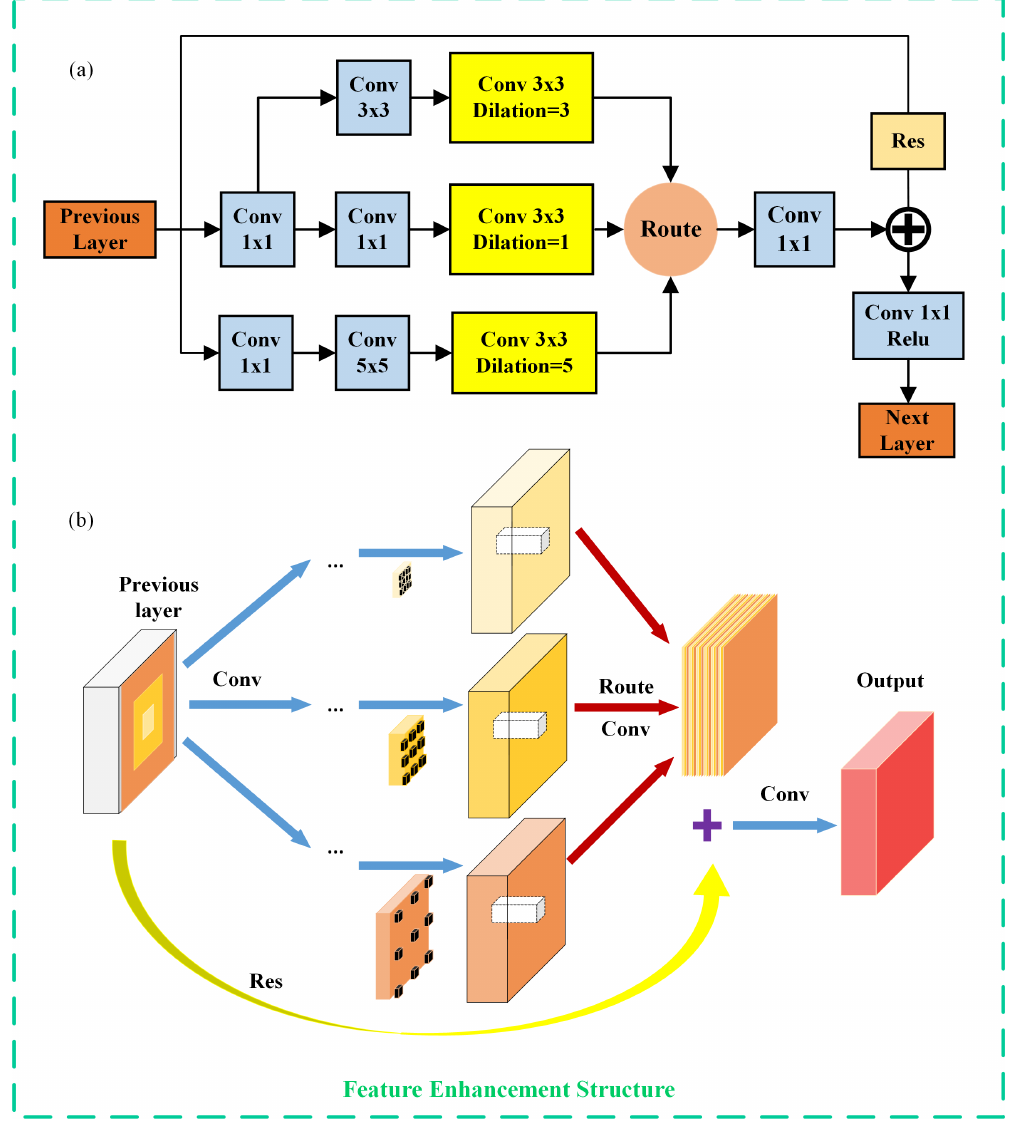
Figure 6. Feature enhancement structure. ( a ) The mechanism of Receptive-Filed Enhancement (RFE) module from receptive field; ( b ) the detailed architecture of RFE